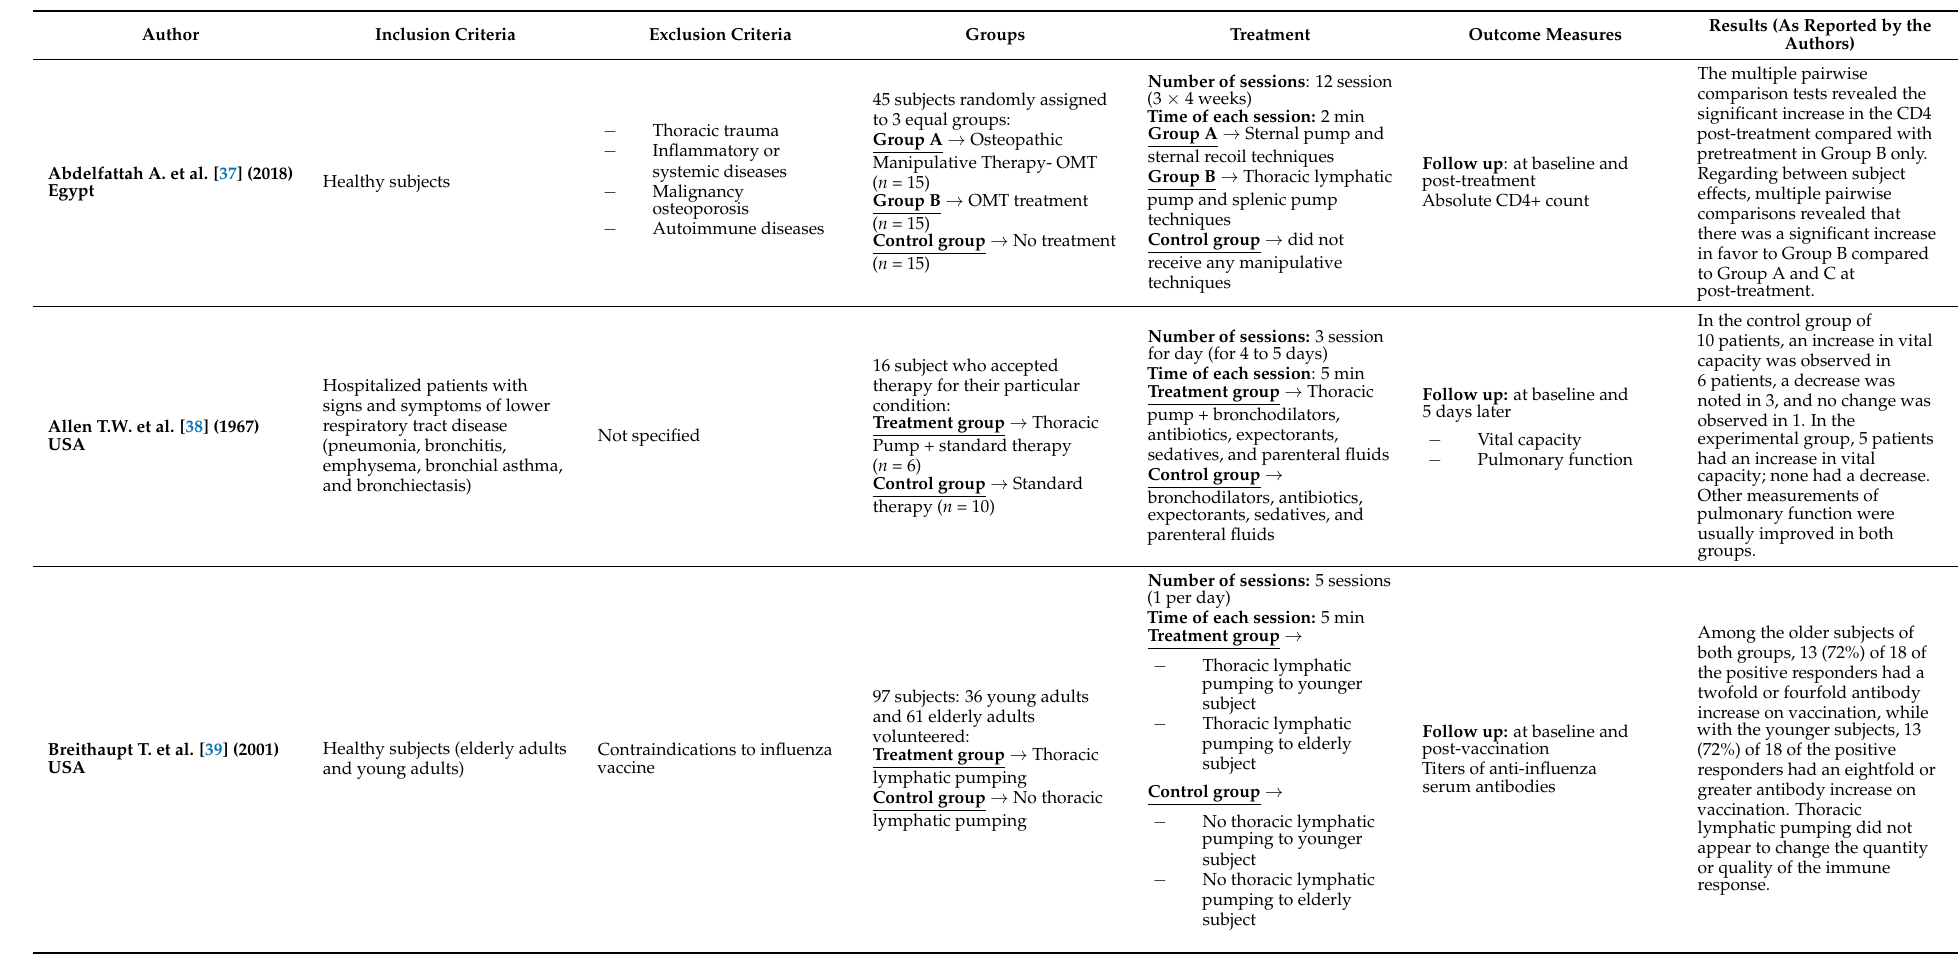
Table 1. Characteristics of the studies on pump